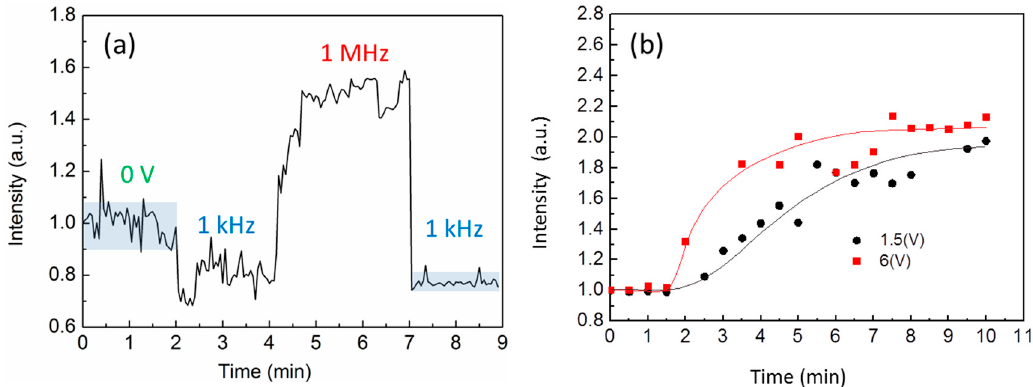
Figure 5. ( a ) The transmission intensity for E. coli solution before and after the dielectrophoresis (DEP) force. The noise was quite large at the start, voltage = 0 V. The signal was quickly decreased to time for different input the initial level when the frequency was changed to 1 kHz; ( b ) The transmission intensity as a function of time for different input voltage.